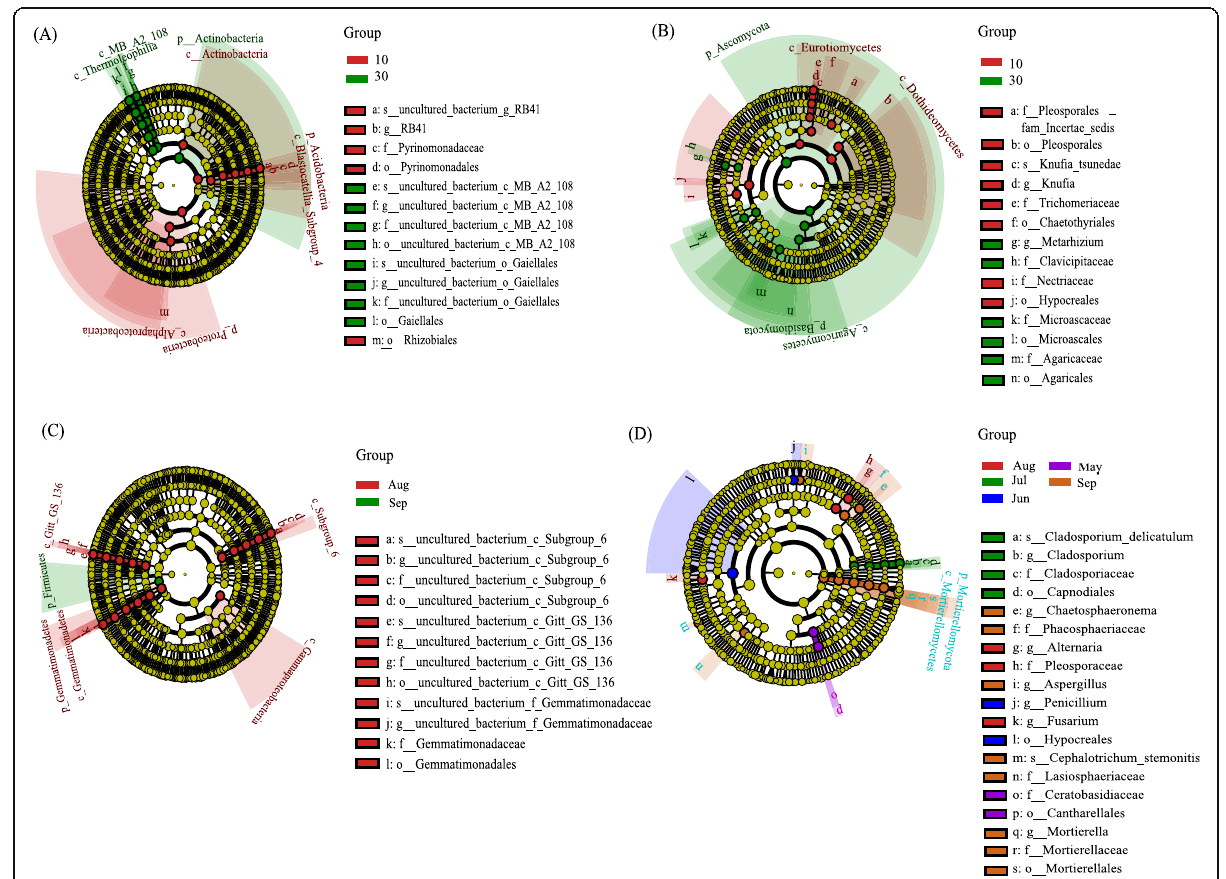
Fig. 2 LEfSe analysis of soil bacteria and fungi. a , b represent bacteria and fungi at different soil depths and shows species with LDA Score more than 4.0, and c , d represent bacteria and fungi in different months and shows species with LDA Score more than 3.5. P value is less than 0.05, and different colors indicate species in different groups. 10 and 30 respectively represents 10 cm and 30 cm. May, Jun, Jul, Aug, and Sep respectively represent sampling in May, June, July, August, and